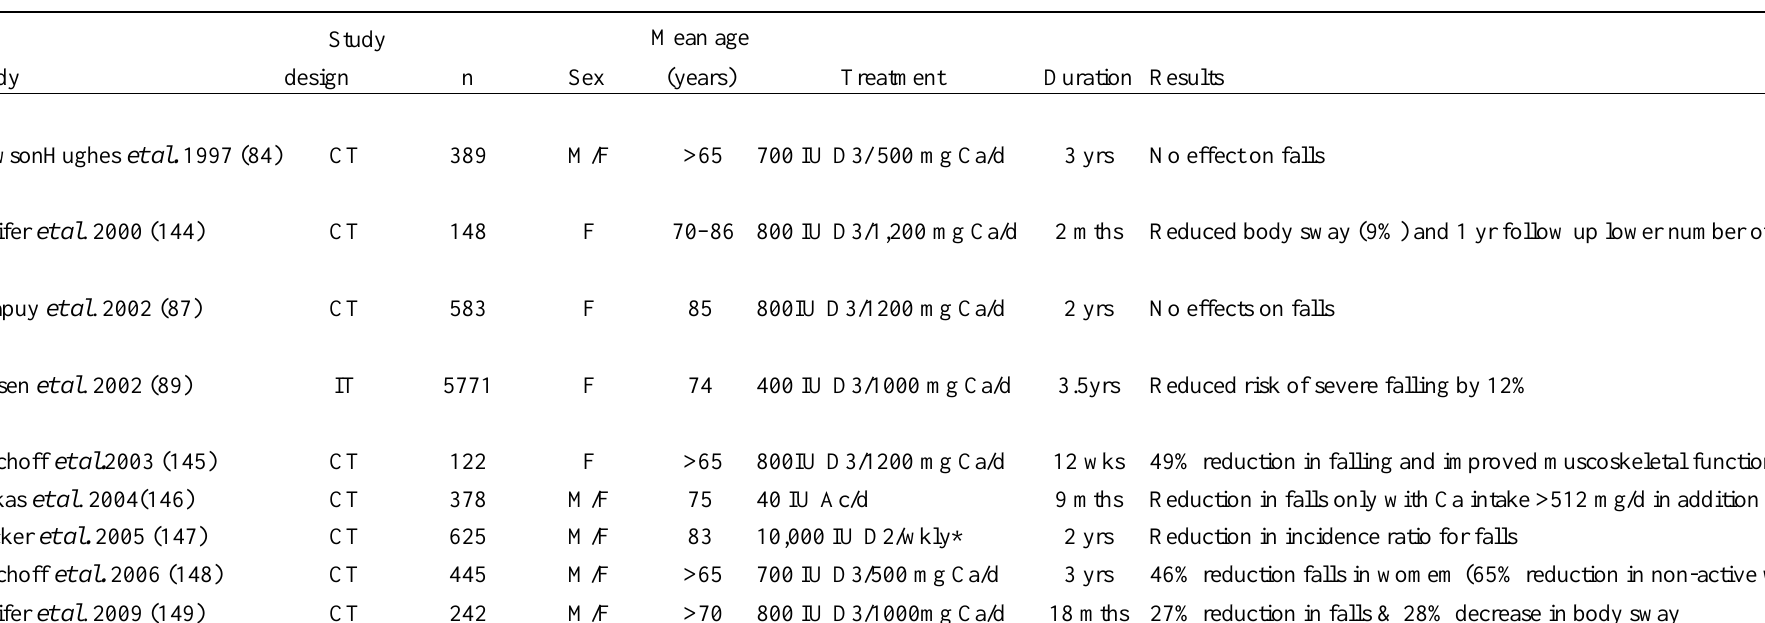
Table 7. Intervention with vitamin D or vitamin D analogues (with / without calcium) on